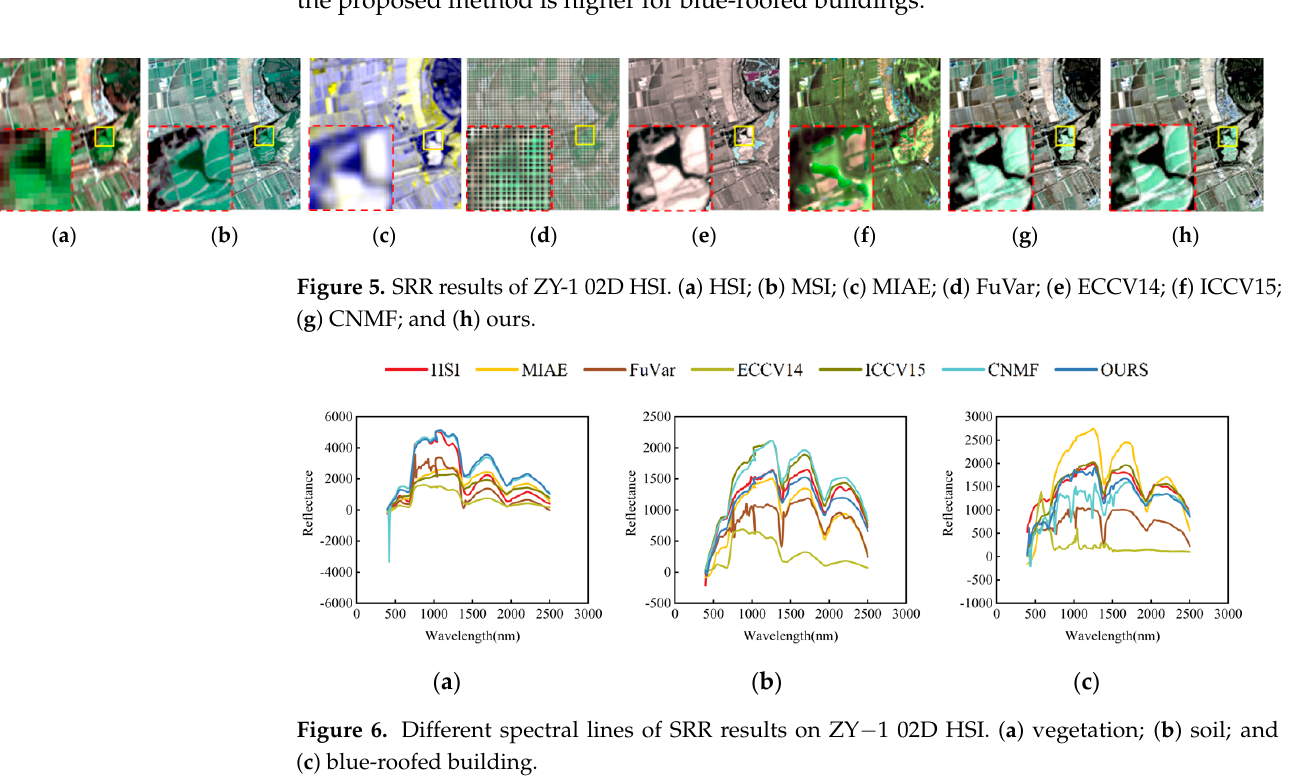
Figure 6. Different spectral lines of SRR results on ZY − 1 02D HSI. ( a ) vegetation; ( b ) soil; and ( c ) blue-roofed building.